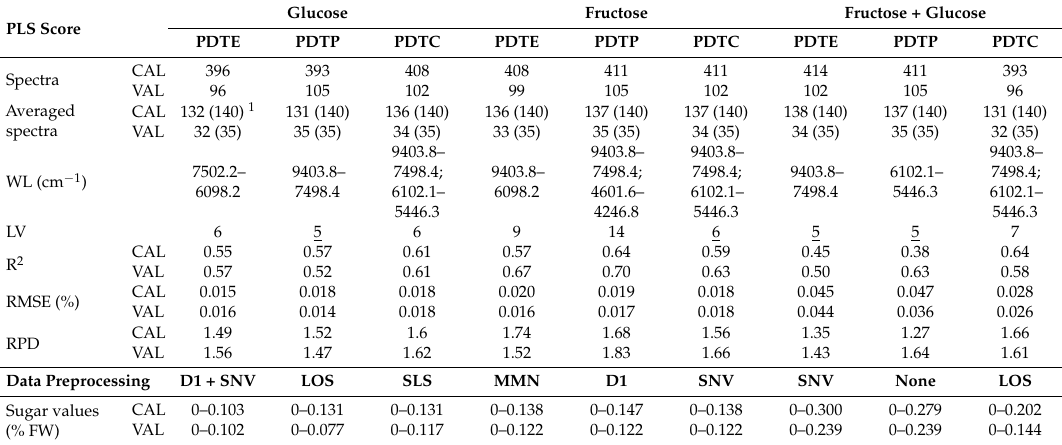
1 number of averaged spectra or potatoes before elimination of outlayers. CAL: calibration, VAL: validation; spectra: number of spectra or potato samples; LV: the number of latent variables; R 2 : determination coefficient; RMSE: root mean square error; RPD: ratio performance to deviation; SNV: Vector normalization; LOS: Linear offset subtraction; MMN: Min–Max Normalization; D1: first derivative; SLS: Straight line